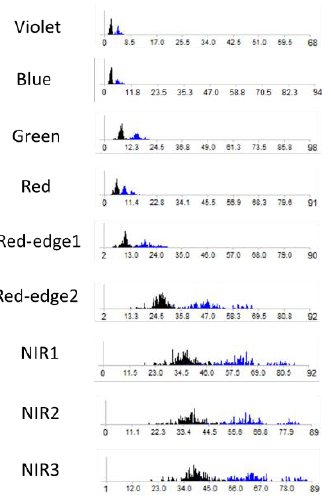
Figure 4. Separability between the training samples of non- lodged (black) and severe (blue) classes in different bands.